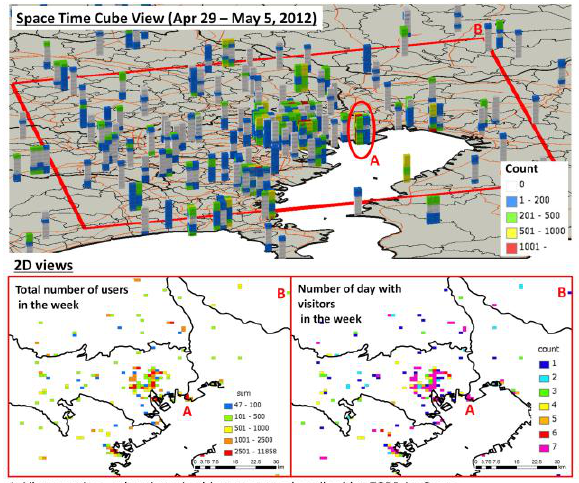
Figure 5. Spatio-temporal distribution of Event Meshes in a week from April 29 to May 5 in 2012 around Tokyo metropolitan area by the space time